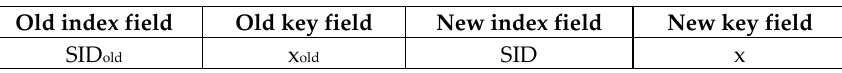
Figure 5. Tags’ index data table in our proposed scheme.